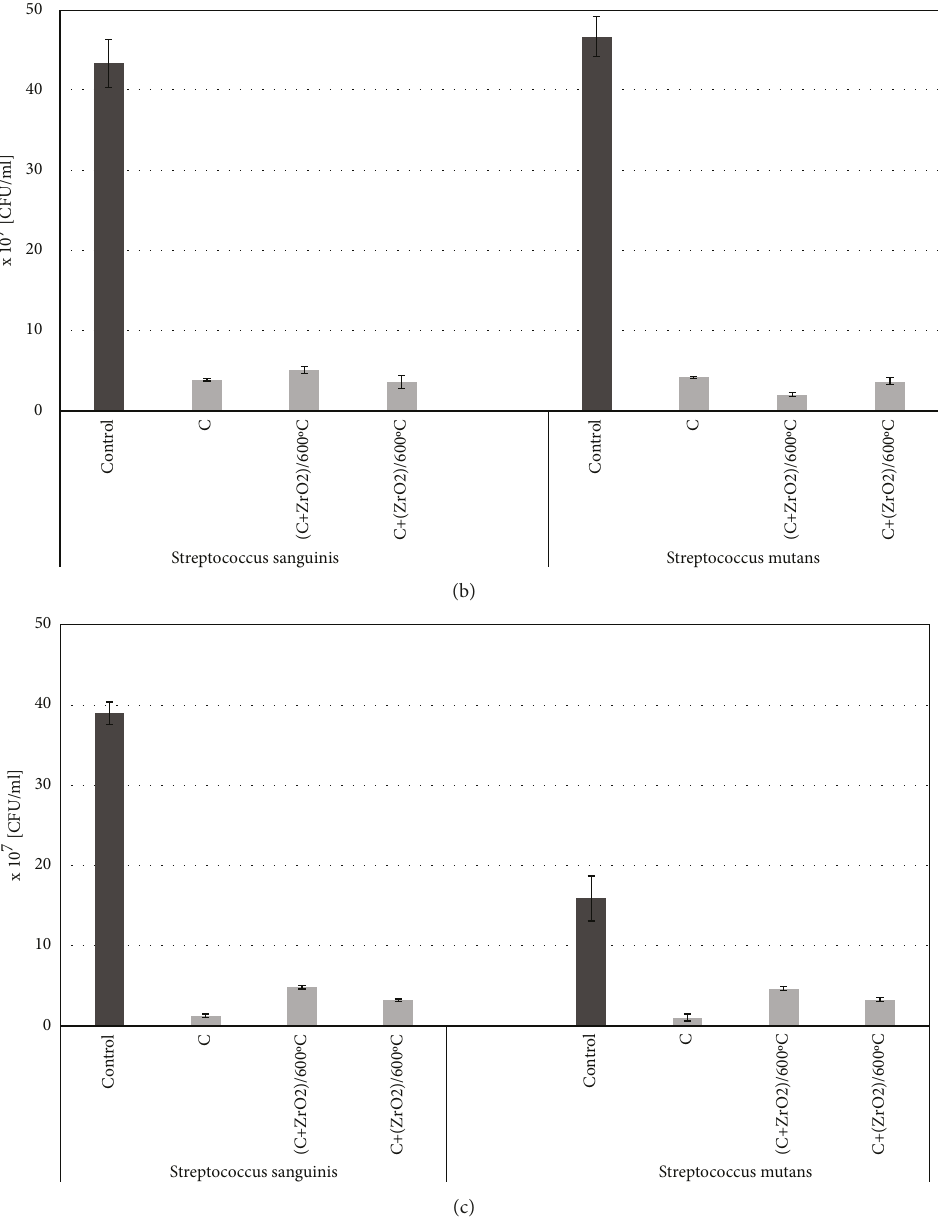
Figure 6: Antibacterial activity of tested cements against Streptococcus mutans and Streptococcus sanguinis after incubation for (a) 24h (b) 48h, and (c) 7 days. This figure shows the number of viable